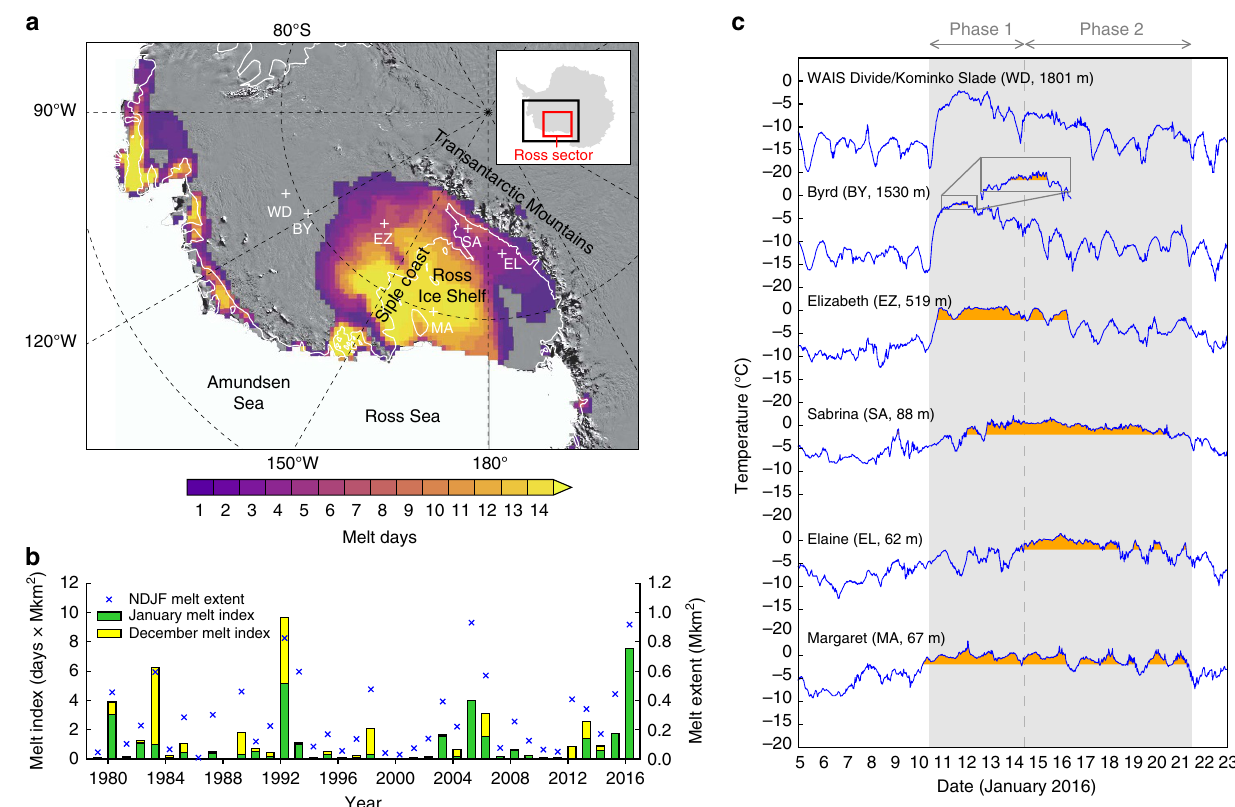
Figure 1 | The January 2016 melt event captured by satellite and surface observations. ( a ) Map of West Antarctica showing the number of melt days in January 2016 estimated from passive microwave satellite observations overlaid on a MODIS mosaic image 62 . The white crosses denote the locations of the automatic weather stations (AWSs) shown in c . The inset map outlines the boundaries of the background MODIS image (black line) and Ross sector (red line). ( b ) Time series of December and January melt index (bars) and November–February melt extent (blue crosses) calculated for the Ross Sector (see inset map in a ) and estimated from satellite-based daily melt data. The year refers to January (for example, the 1992 melt indices are December 1991 and January 1992). No data are shown for 1988 owing to insufficient observations. ( c ) Time series of 10-minute near-surface temperatures from six West Antarctic AWSs whose locations are shown in a . AWS name abbreviation and elevation above sea level are given in parentheses. Orange shading highlights temperatures above (cid:2) 2 (cid:2) C (surface melting can occur despite below-freezing near-surface temperature because of radiative